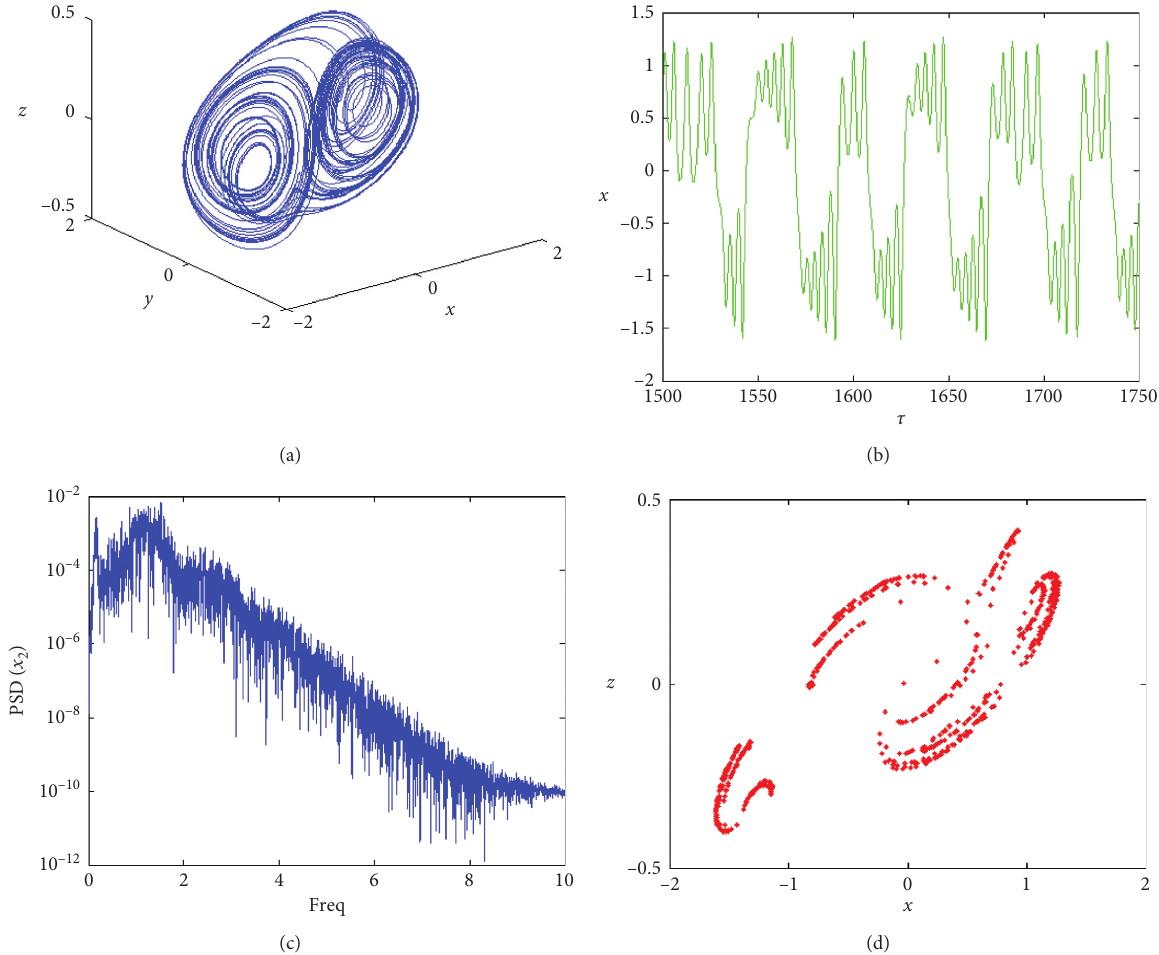
Figure 6: Three-dimensional portrait (a), time series (b), frequency spectrum (c), and Poincar´e section (d), confirming asymmetric chaotic behavior of the system for m � 0 . 25 and b � 0 . 32. The other parameters are specified in the